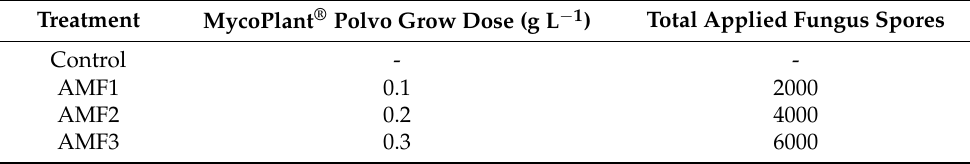
Table 4. Treatments and total Rhizophagus irregularis applied rates.